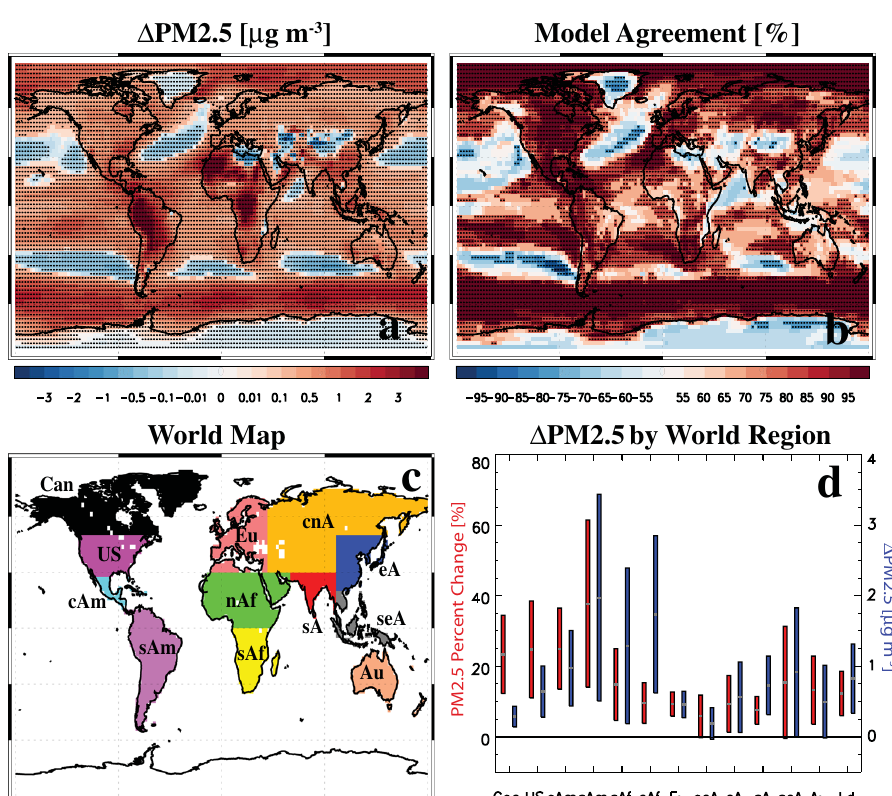
Fig. 1 PM 2.5 response to GHG-induced warming. a Multi-model mean annual mean PM 2.5 response [ μ g m − 3 ]; b model agreement on the sign of the PM 2.5 response [%]; c 12 world regions; and d absolute [ μ g m − 3 ] and relative [%] PM 2.5 response by world region. Dots in a represent a signi fi cant response at the 90% con fi dence level based on a two-tailed pooled t -test. Red (blue) colors in b indicate model agreement on a PM 2.5 increase (decrease). Dots in b represent a signi fi cant model agreement at the 90% con fi dence level based on a two-tailed binomial test. Bar center (gray horizontal line) in d shows the multi-model mean response and bar length represents the 90% con fi dence interval estimated as 1 : 65 ´ σ ffiffiffiffi n p , where σ is the standard deviation across models m and n m is the number of models. The following abbreviations are used: Canada (Can; black), United States (US; magenta), Central America (cAm; sky blue), South America (sAm; purple), south Africa (sAf; yellow), north Africa (nAf; green), Europe (Eu; pink), central and north Asia (cnA; orange), east Asia (eA; navy), south Asia (sA; red), southeast Asia (seA; gray), and Australia (Au; beige). The average over these 12 land regions is abbreviated as “